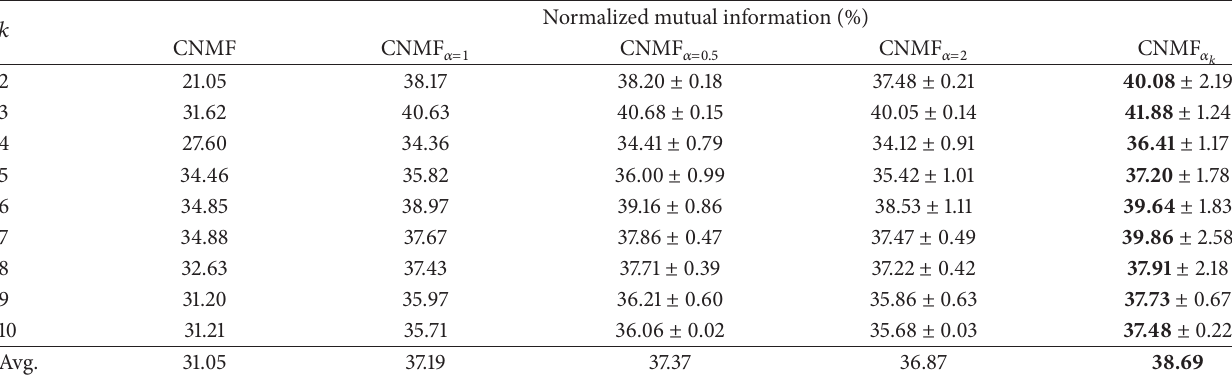
Table 6: The comparison of normalized mutual information on the Caltech 101